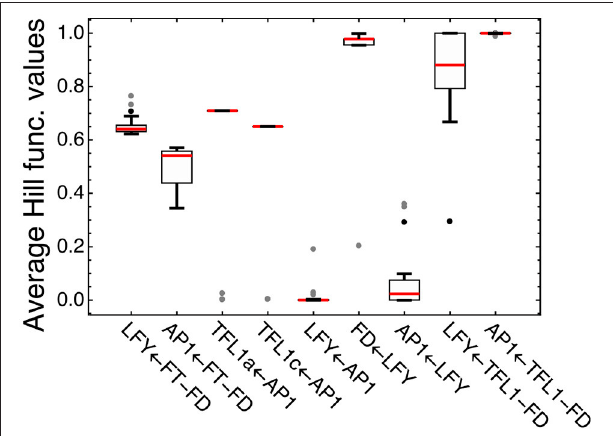
FIGURE 4 | Average values of the regulation functions characterizing regulation in the model for ICCV 96029. For each set of the optimized parameter values, the averaged values of the regulation functions from the model equations were obtained by integrating these functions over time under SD and LD and dividing by the integration time interval; the figure shows box plots of the distributions of these values over all sets of the optimized parameter values. The type of regulation corresponding to each regulation function is shown on the horizontal axis, where arrow indicates the direction of the regulation. FT-FD and TFL1-FD denote the complexes of FD with all FT and two TFL1 proteins, respectively. Dots show outliers.